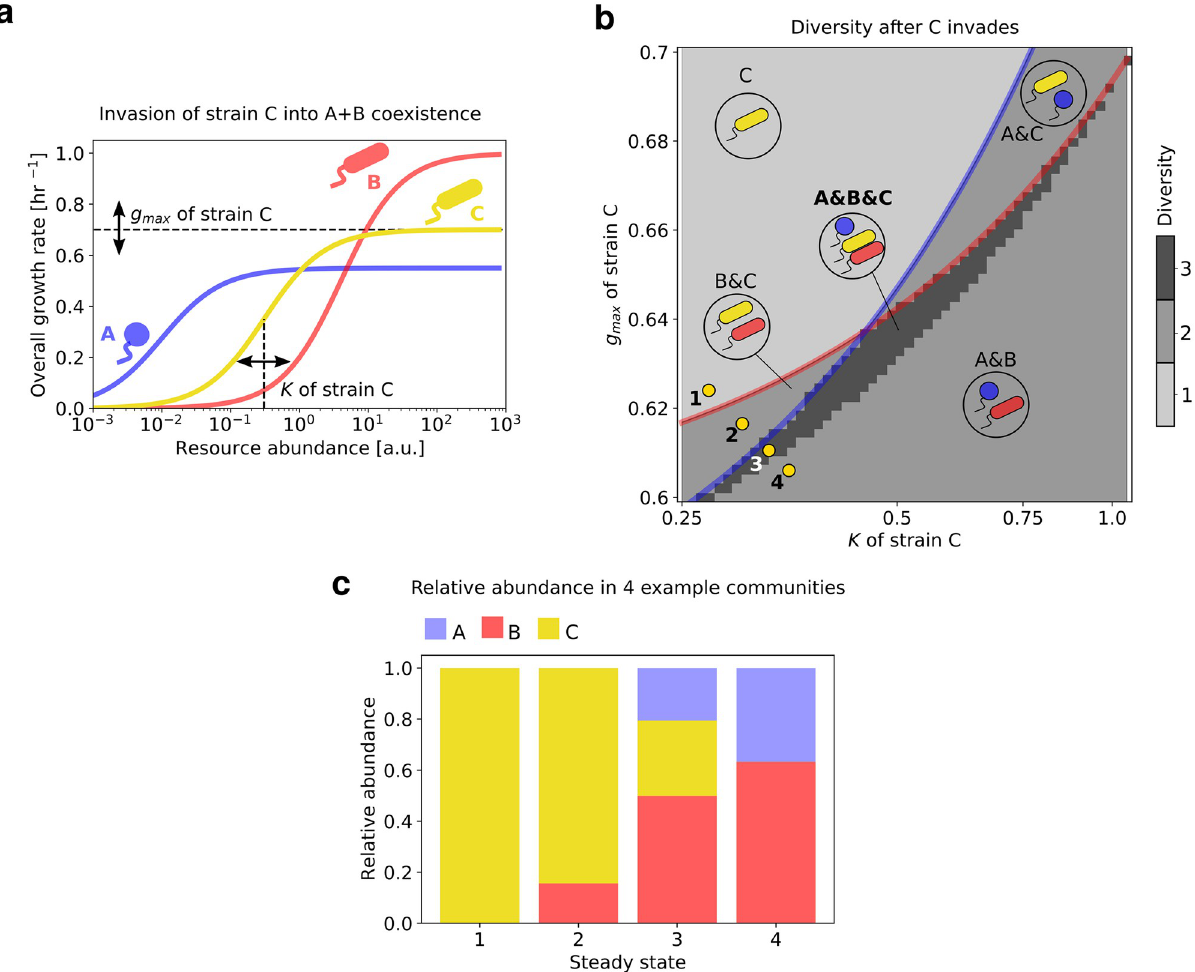
Fig 2. Three-strain coexistence in a boom and bust environment on a single resource. (a) Growth rate profiles of strains A , B and C , which all obey Monod growth. We fixed the parameters g max and K for strains A (blue) and B (red), and varied them for strain C in a manner that both g C and K C remained between those of strains A and B . (b) Heatmap showing the steady state community diversity (number of coexisting strains) as a function of and K . In the region above the solid blue line, A goes extinct, above the red line, B goes extinct. The yellow dots represent 4 the growth parameters g C C variants of C corresponding to 4 qualitatively distinct steady state community compositions, shown as stacked bar plots of relative abundances in (c) .